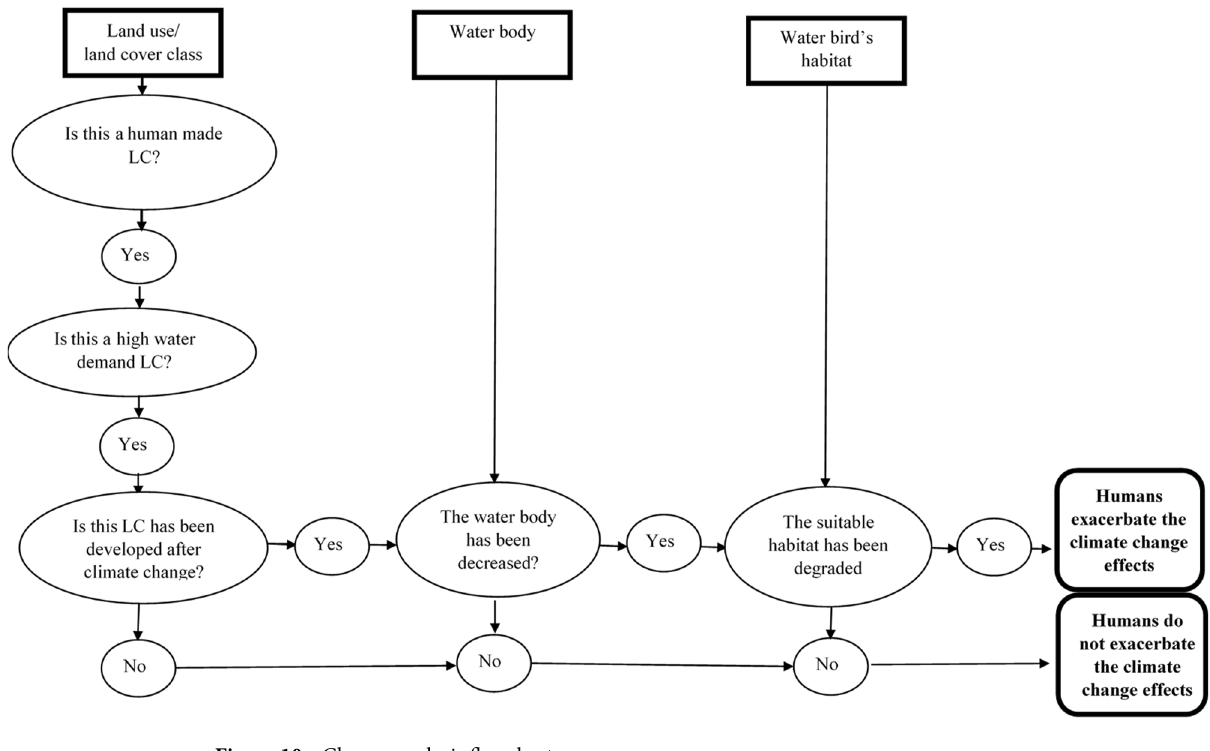
Figure 10. Change analysis